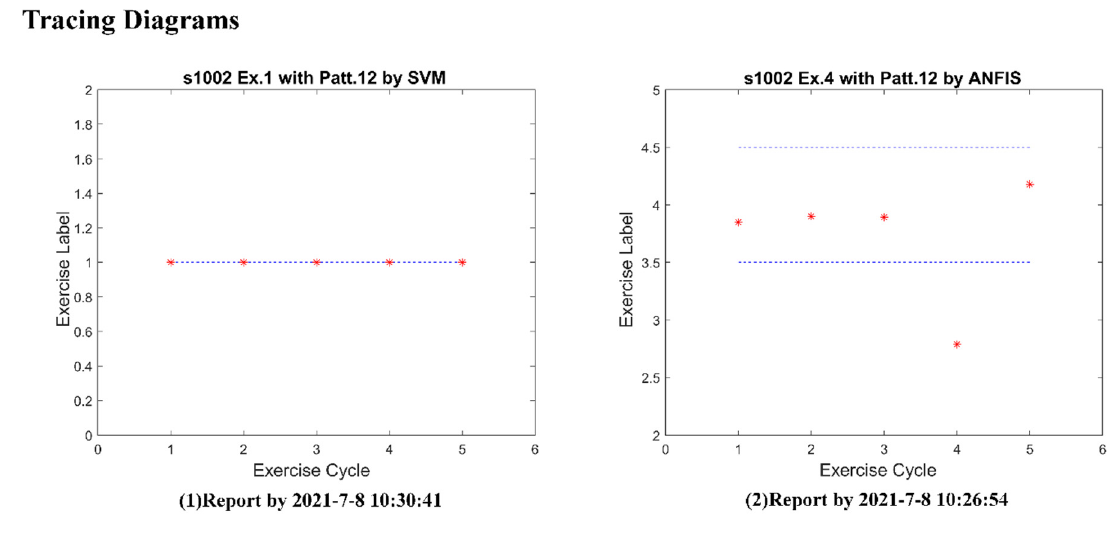
Figure 8. Core interface snapshots of the AIoT-enabled PRR system prototype for rehabilitation recognition management